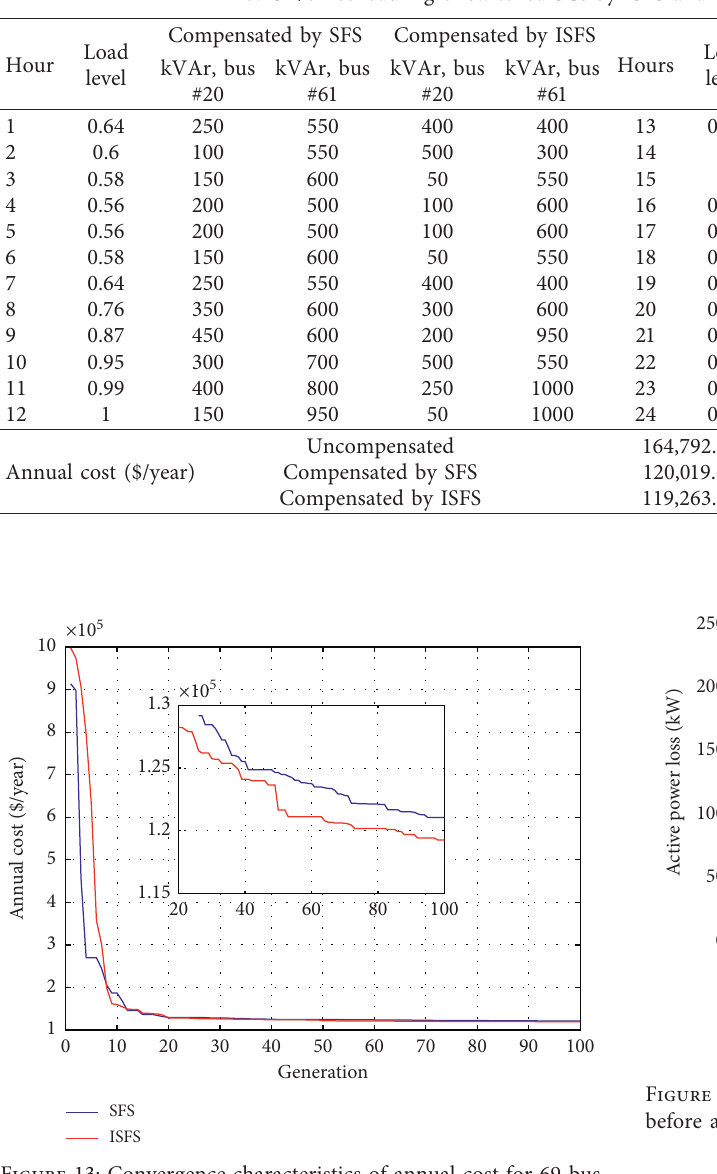
Table 5: On/off scheduling of switched SCs by ISFS and SFS for 69-bus network in scenario 2.